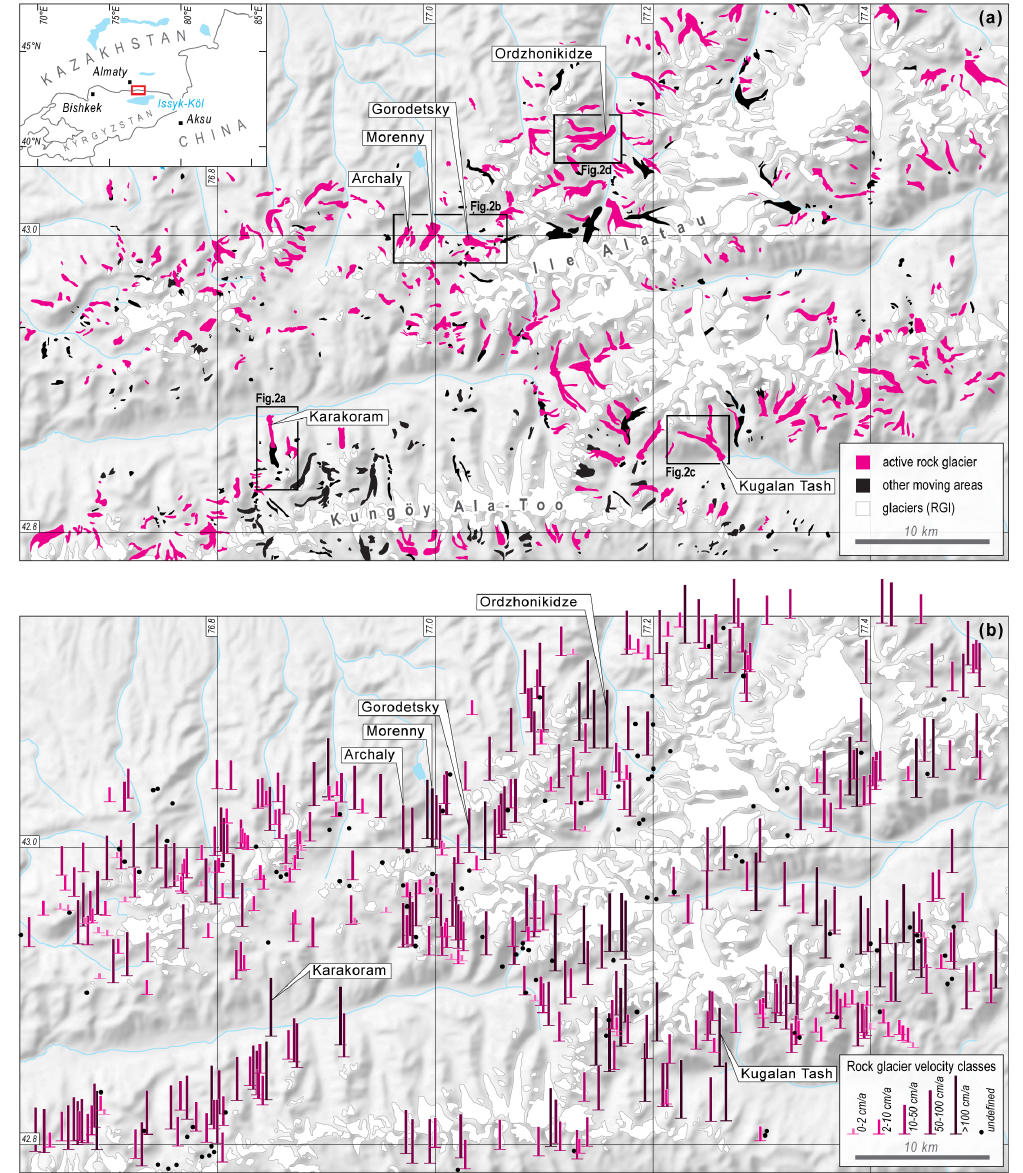
Figure 1. (a) Movement inventory of rock glaciers and other forms of surface deformation over parts of the Ile Alatau and Kungöy Ala-Too, northern Tien Shan. (b) Displacement rates are based on satellite radar interferometry, and interpretation of process types is based in addition on high-resolution optical satellite images. The glacier mask is from the Randolph Glacier Inventory (RGI) (Pfeffer et al., 2014). The panel to the upper left indicates the location of the study area (red rectangle). The labels in (a) point to the rock glaciers of which photogrammetric time series of surface speed were constructed, and the rectangles point to detail panels in Fig. 2. Note that the full inventory is available online with all attributes in GIS format (see Data availability